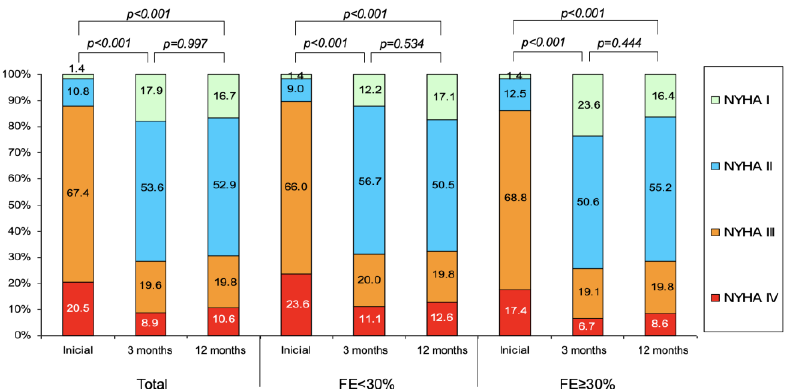
Figure 3. Modifications over time in NYHA functional class during follow-up in the entire series and according to LVEF. NYHA, New York Heart